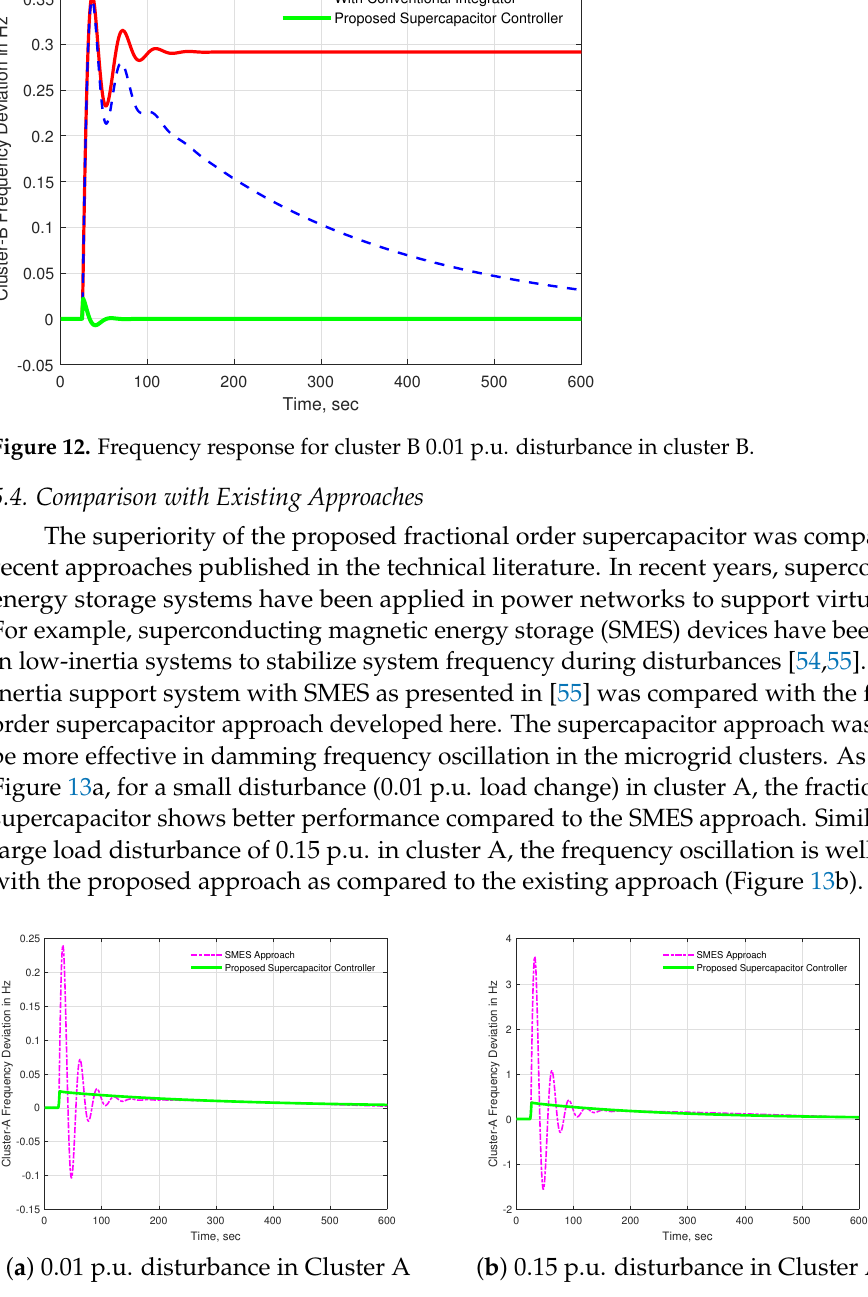
Figure 13. Comparison of frequency deviation in